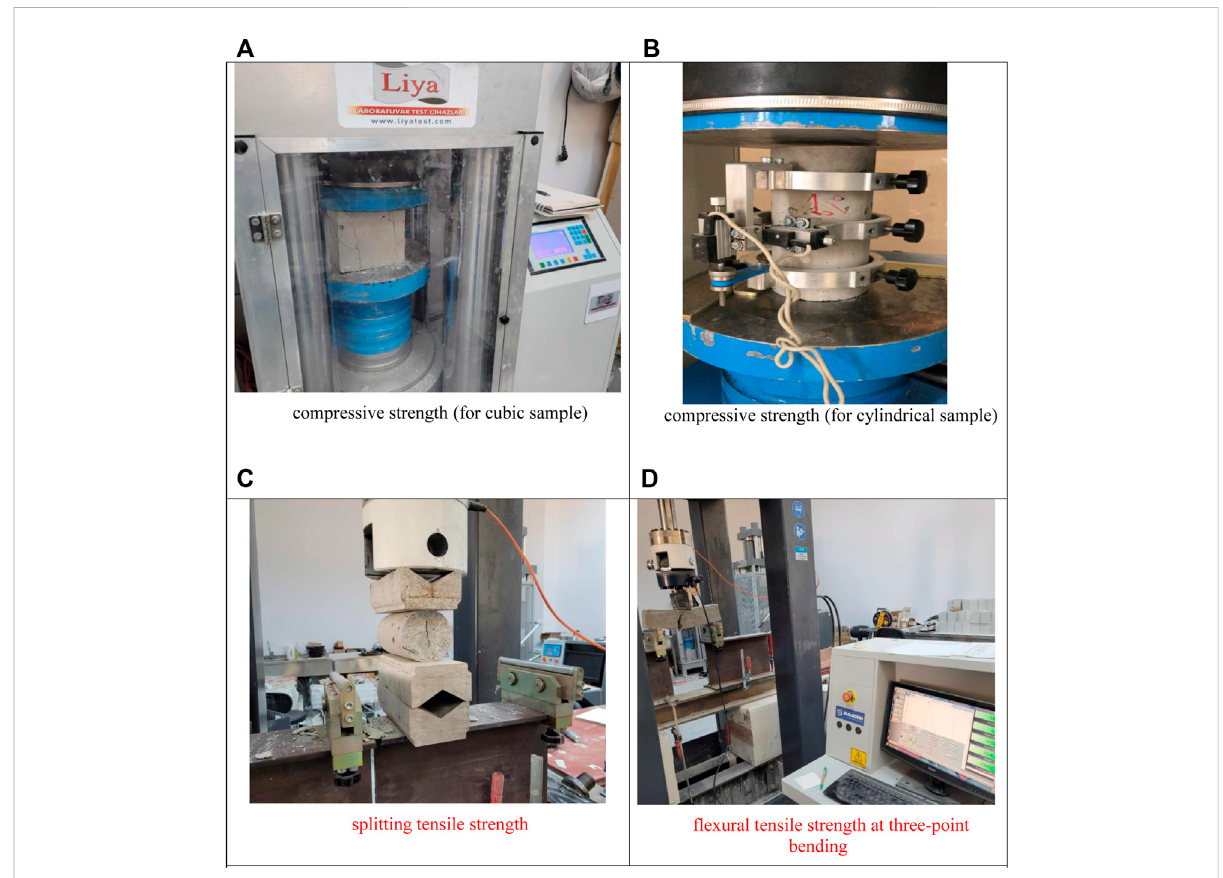
FIGURE 3 Mechanicaltestsetups (A) compressivestrength(forcubicsample) (B) compressivestrength(forcylindricalsample) (C) splittingtensilestrength (D) fl exural tensile strength at three-point bending.